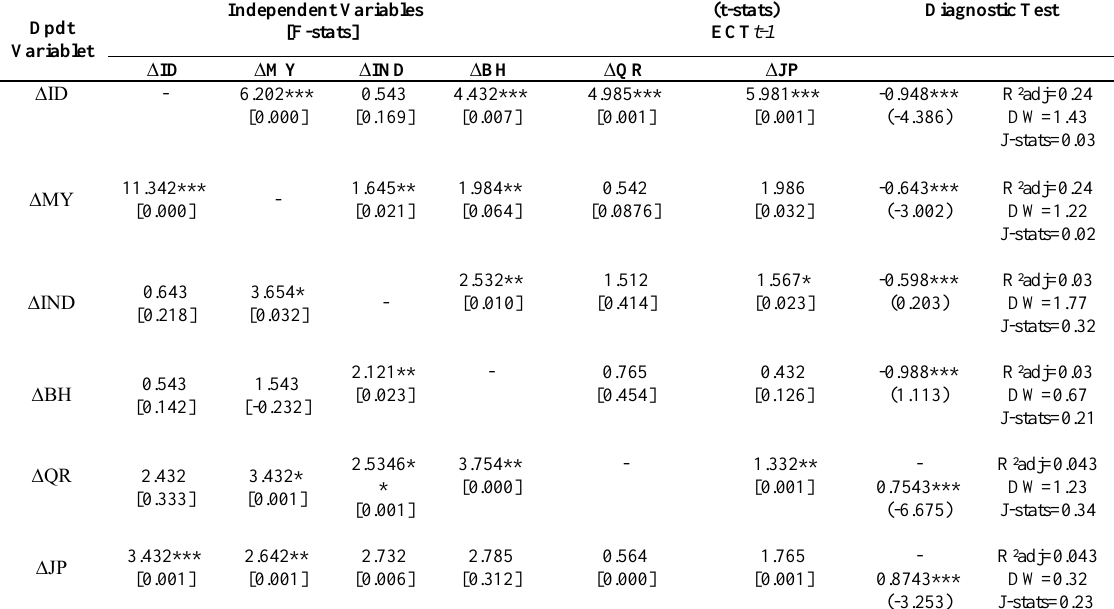
Table 5 Result of Multivariate VECM Analysis (Model: ID, MY, IND,